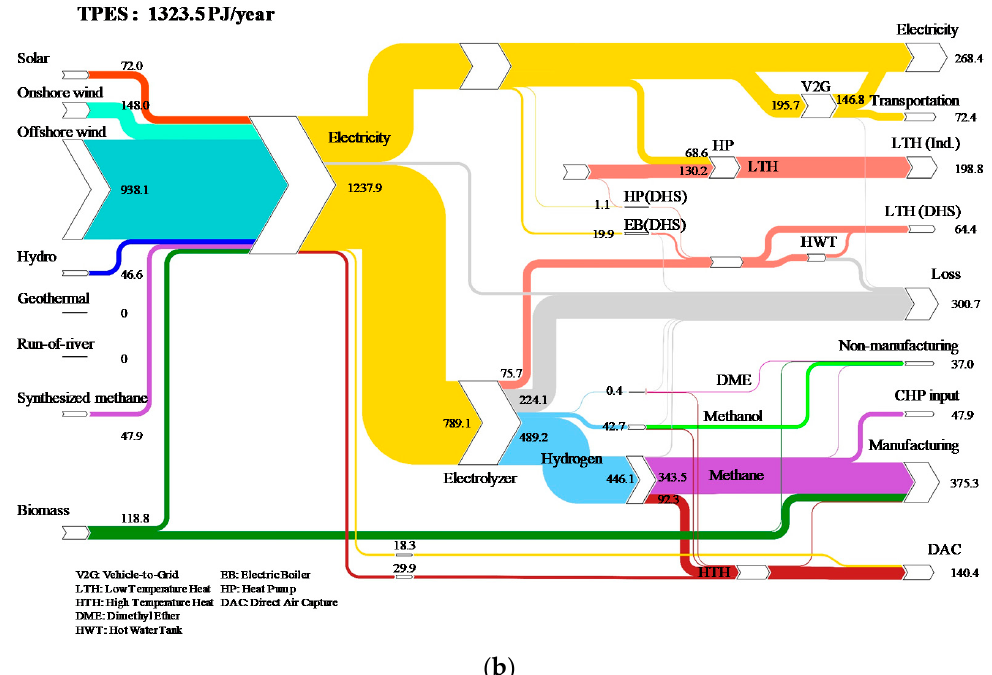
Figure 8. The energy flow chart in the Tohoku region. ( a ) Current energy system. ( b ) The sector-coupled energy system in the case of the All-BEV-V2G_HD120 scenario.